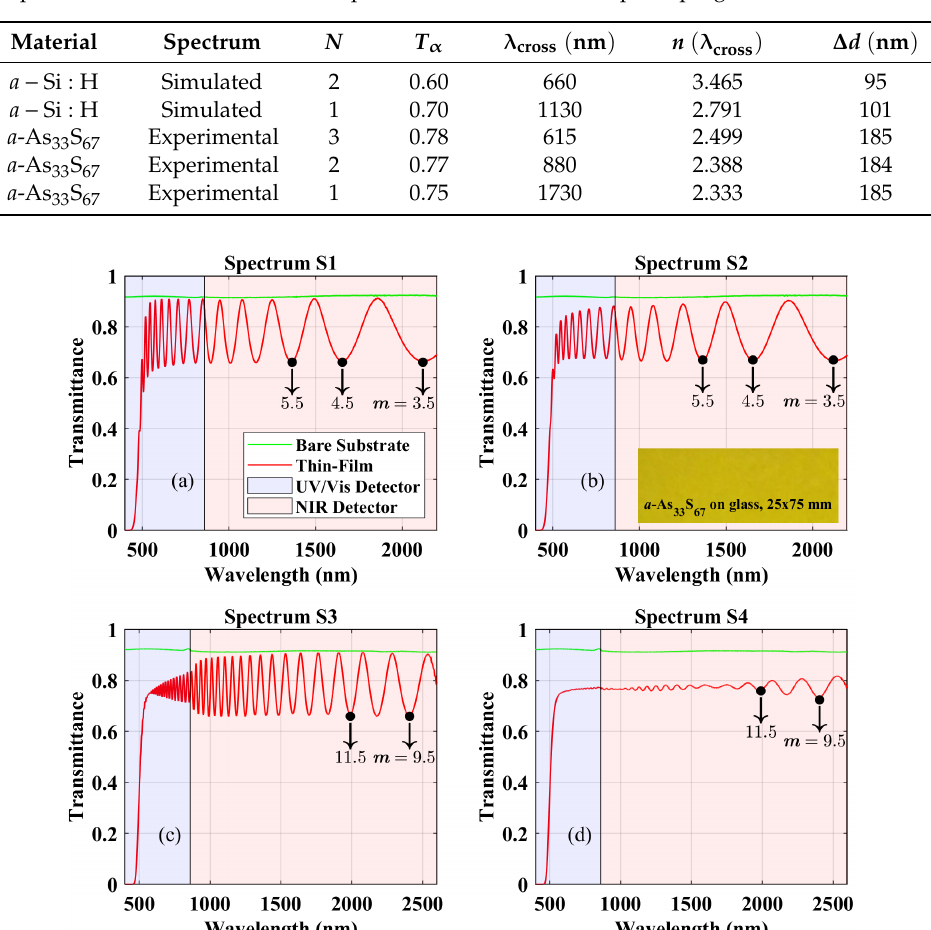
Figure 5. Optical transmission spectra for two thermally-evaporated chalcogenide samples deposited onto room-temperature glass substrates, at two cross positions of each specimen (as shown in Figure 1b). Panels ( a ) and ( b ) correspond to the transmission spectra of the thinner layer, and panels ( c ) and ( d ) to the spectra of the thicker layer. A photo of an amorphous arsenic sulfide film is displayed as an inset in the figure.